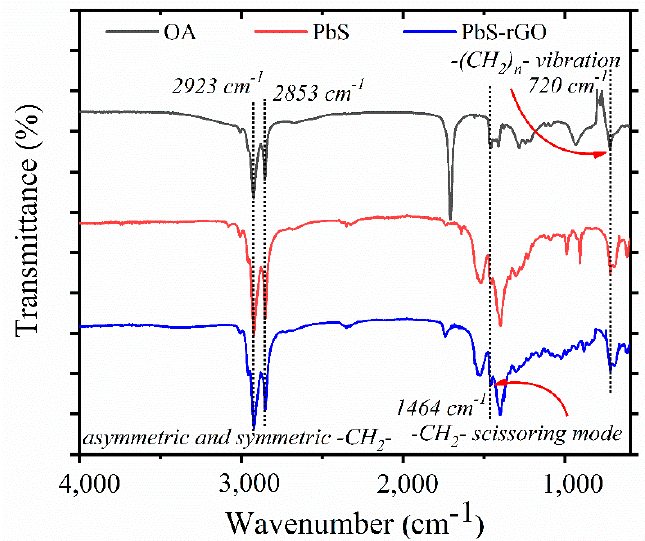
Figure 4. FTIR spectra of oleic acid, PbS QDs and rGO–PbS hybrid, indicating the presence of oleic acid.